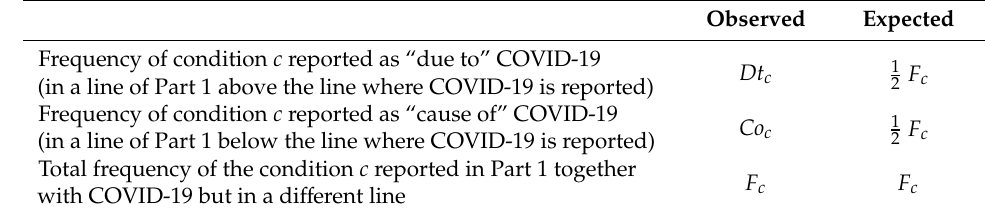
Table A1. Comparison between observed and expected.